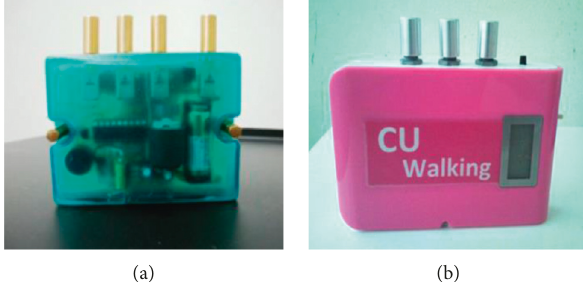
Figure 1: CONSORT flow